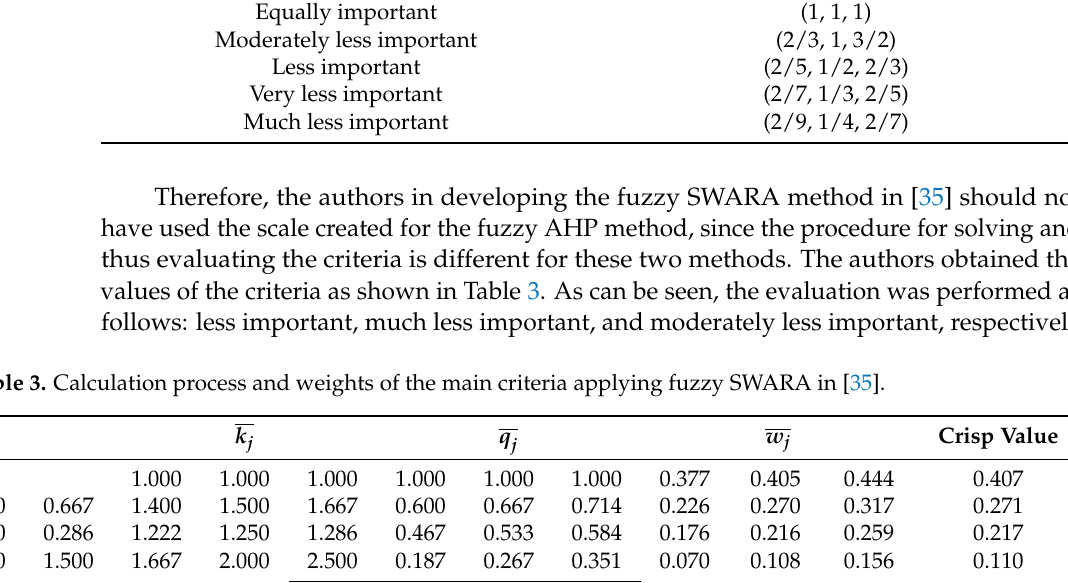
The calculation below instead applies the improved fuzzy SWARA (IMF SWARA) (Table 4) method developed in this paper using the same linguistic variables: LS, MLS, and MDLS in order to show differences in the obtained fuzzy